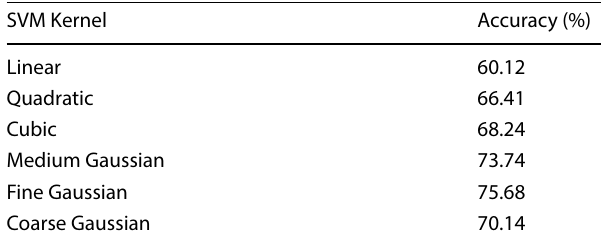
Table 1 Accuracy of different SVM kernel functions SVM Kernel